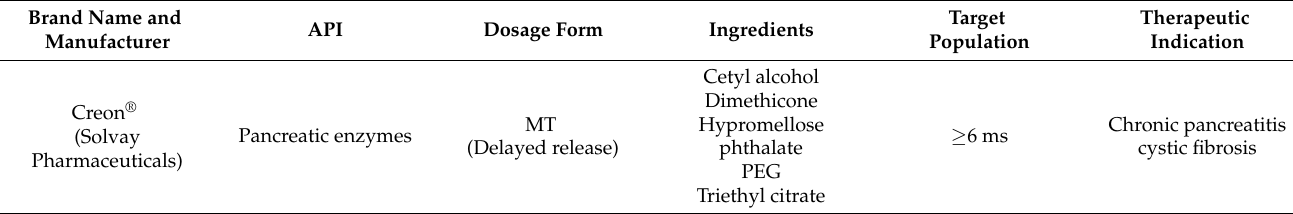
Table 4. Main commercially available